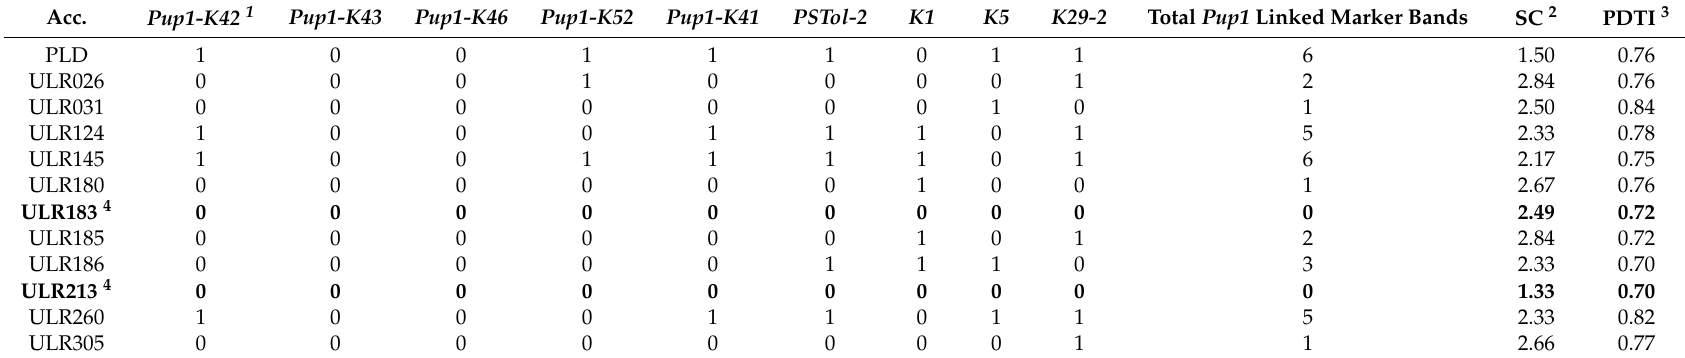
Table 3. Genotyping of the top 12 rice genotypes tolerant to P deficiency by Pup1 -linked markers against plant symptom (SC) and Phosphorus deficiency tolerance index (PDTI)